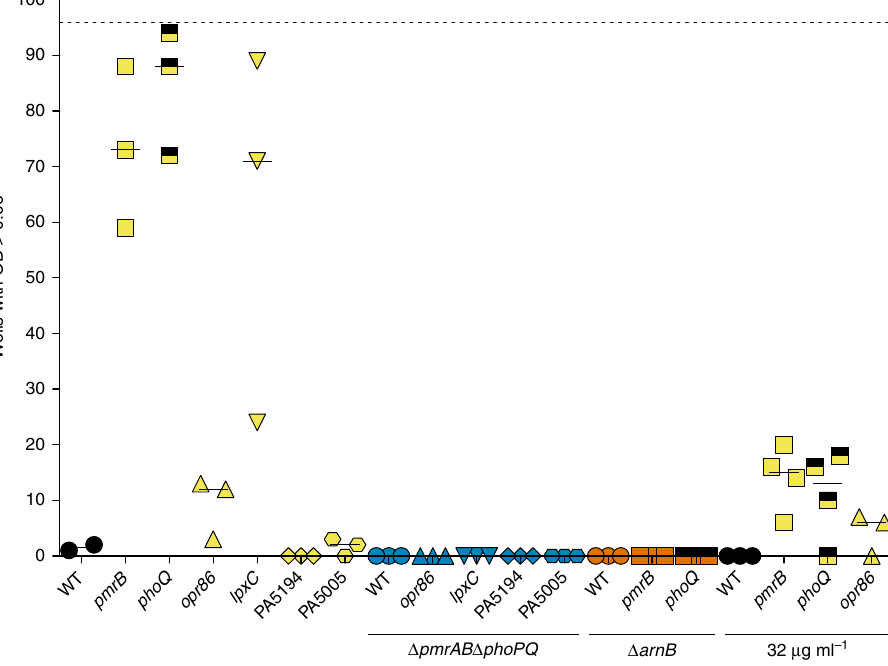
Figure 5 | Mutations in regulators potentiate evolution of high-level colistin resistance. Relative estimates for frequency of resistance to 16 m gml (cid:2) 1 colistin (unless otherwise indicated) was determined for different strains of P. aeruginosa PAO1 using 96-well microtiter plate assays. Plates were scored for growth after 48 hrs by measuring optical density (OD) at 600nm. Resistance as growth was scored for wells with OD 4 0.06. Dotted horizontal line, number of wells (96) investigated; wildtype (WT) P. aeruginosa PAO1; pmrB , phoQ , opr86 , lpxC , PA5194 and PA5005, P. aeruginosa allelic replacement mutants with mutations from SNRC or SNRD ( phoQ 779T 4 G ). D pmrAB D phoPQ , genes encoding the two-component systems were deleted; D arnB arnB gene of the LPS modification operon was deleted. Each point represents a single experiment. In some cases more than one symbol occupies the same space. Horizontal lines show the median for each strain. Results are based on at least three biological